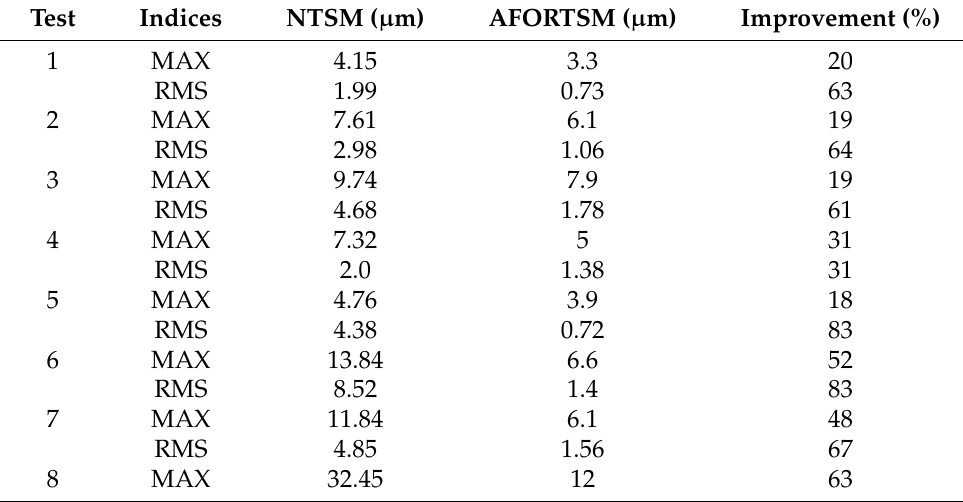
Table 2. Summary and comparison of experimental